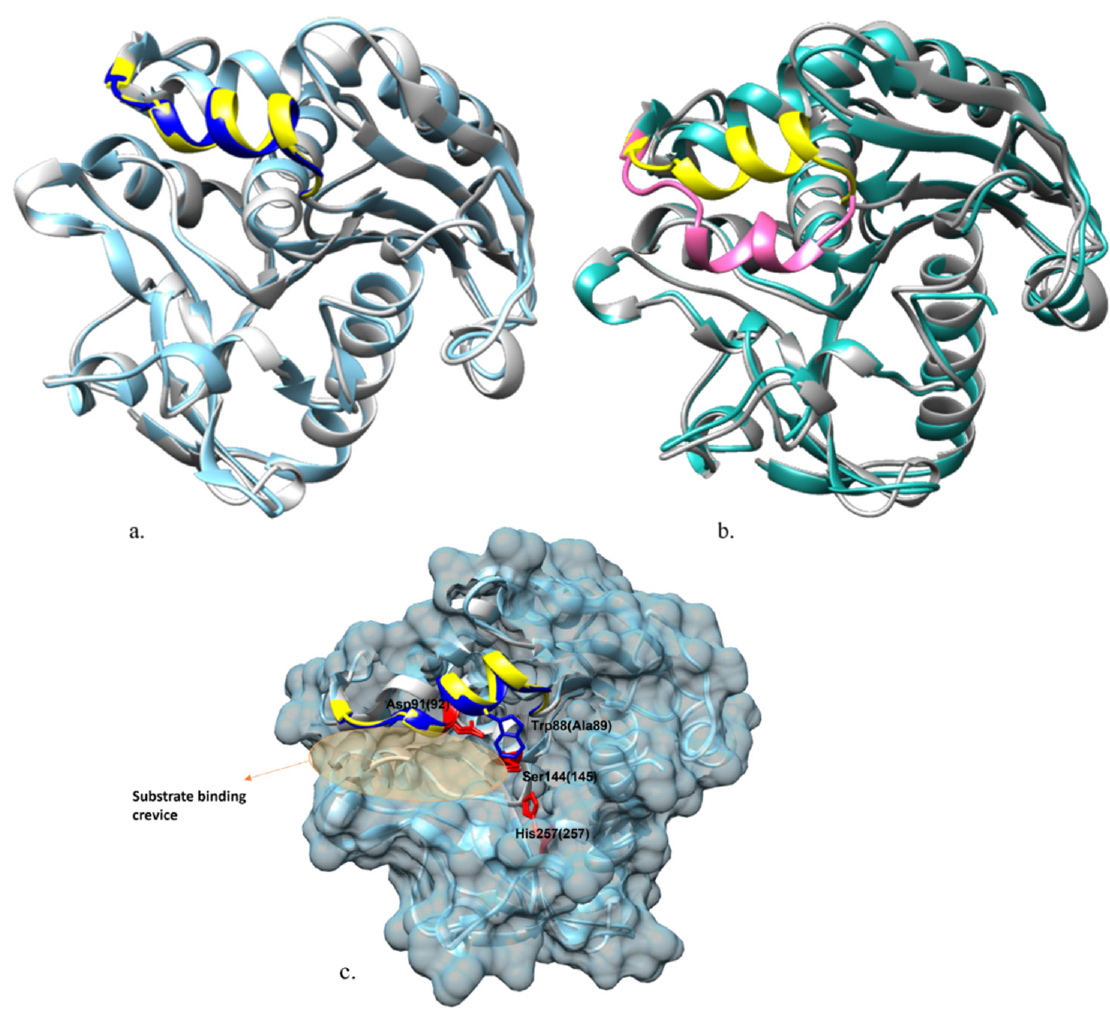
Figure 4. Superposing ROLop (grey) on relevant crystal structures: ( a ). Open-lid RML crystal structure 4TGL (ice blue). Yellow: lid region of the homology model; blue: lid region of 4TGL. ( b ). Closed lid ROL crystal structure 1LGY (cyan). Yellow: lid region of the homology model; hot pink: lid region of 1LGY. ( c ). ( b ) Catalytic essential characteristics identified including the catalytic triad shown in red and substrate binding crevice specified.